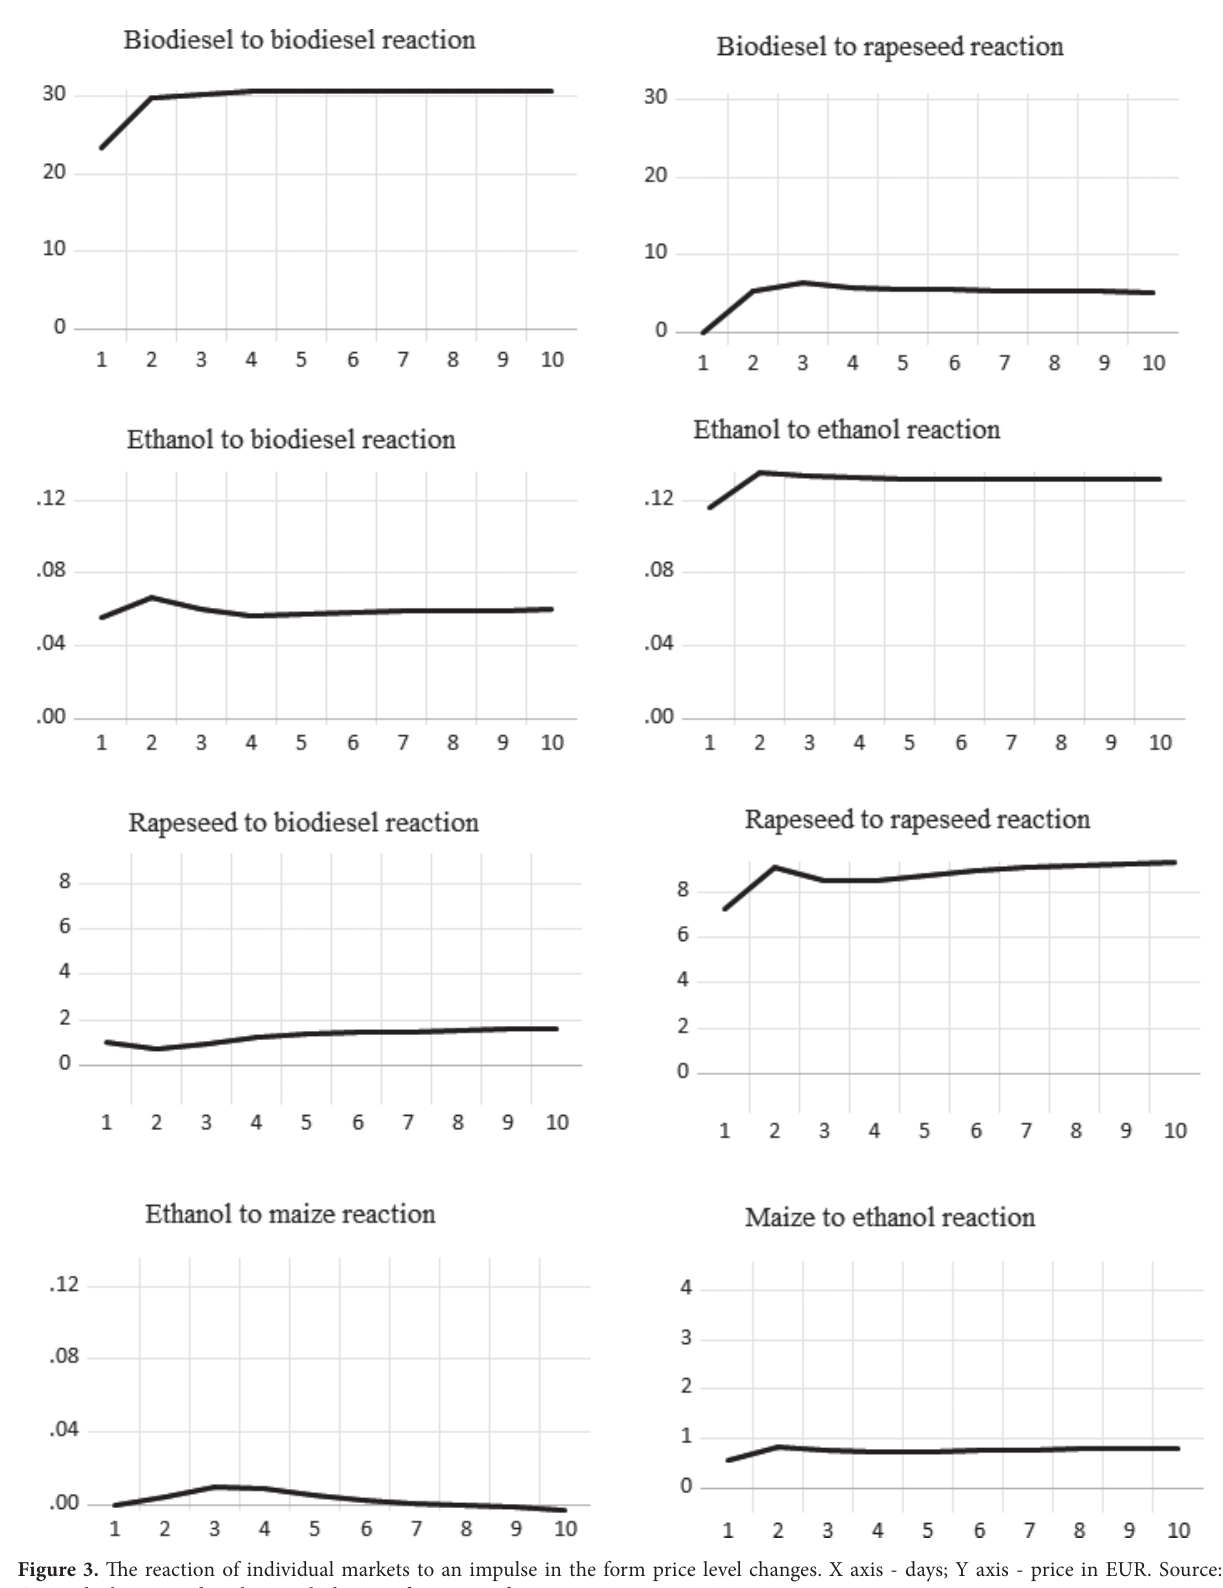
Figure 3. The reaction of individual markets to an impulse in the form price level changes. X axis - days; Y axis - price in EUR. Source: Own calculations and analysis with the use of EViews